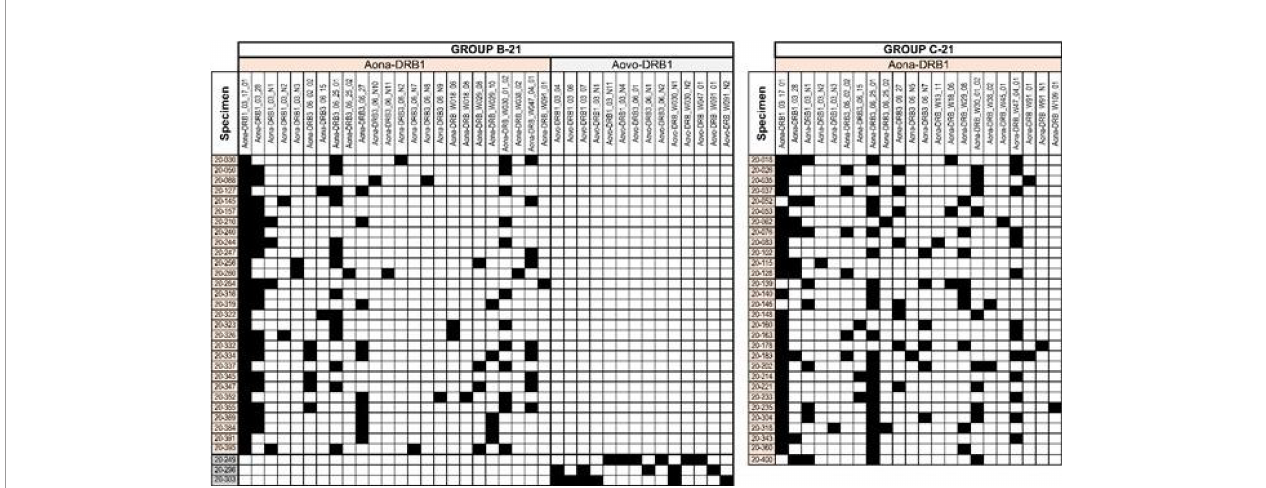
FIGURE 11 | MHC-DRB typing of Aotus monkeys used in the trials. The Illumina NovaSeq sequencing system was used for typing the exon 2 amplicon. A. nancymaae monkeys ’ alleles are indicated in beige, A. vociferans in grey. The fi gure indicates the amount of monkeys in which the typed alleles were detected (row) and the amount of alleles per monkey (columns) for B-21 and C-21 . Figures 5 – 7 show genotyping correlated with matching HLA-DR b 1* alleles. The other DNA samples were not suitable for sequencing. The Illumina NovaSeq sequencing platform was used for typing the exon 2 amplicon. A. nancymaae monkey alleles are highlighted in orange and A. vociferans in grey; genotyping was linked with matching HLA-DR1* alleles (as shown in Figures 5 – 7